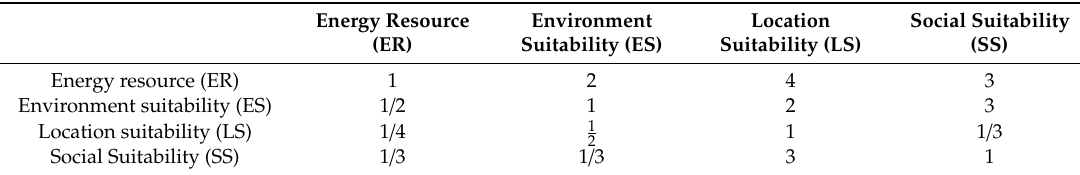
Table 5. Real number